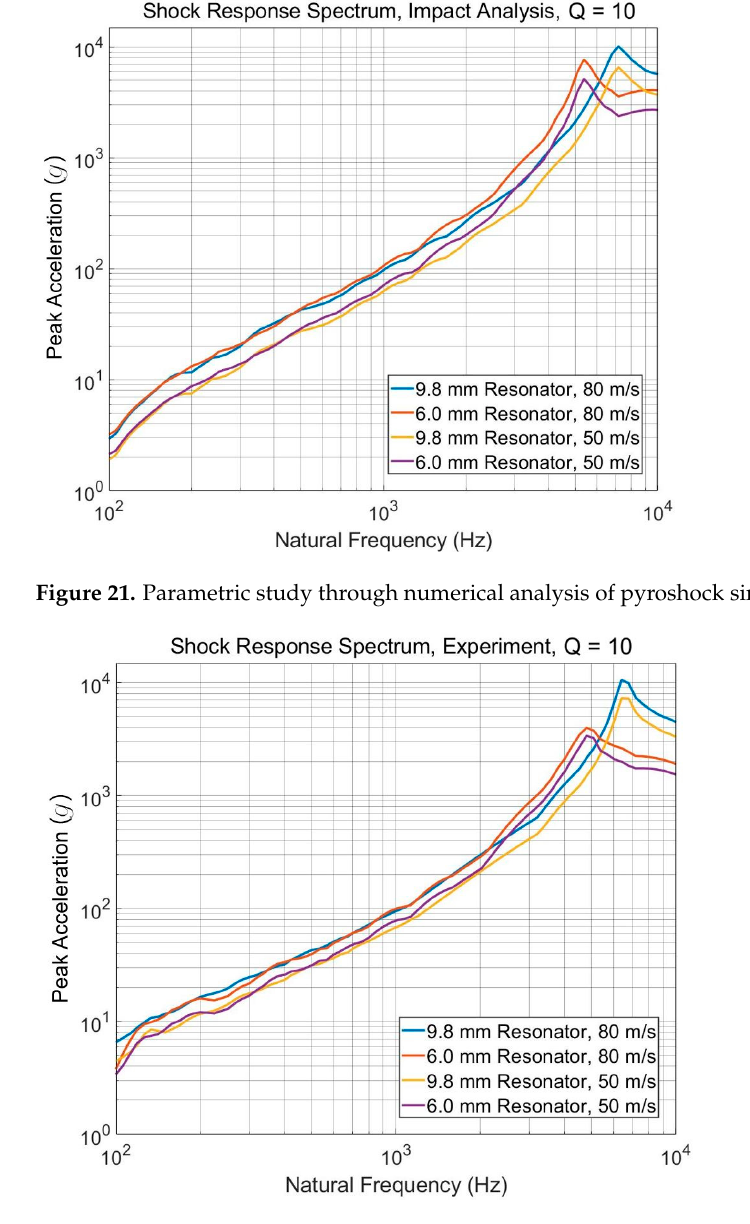
Figure 22. Parametric study through experiments of pyroshock simulator.